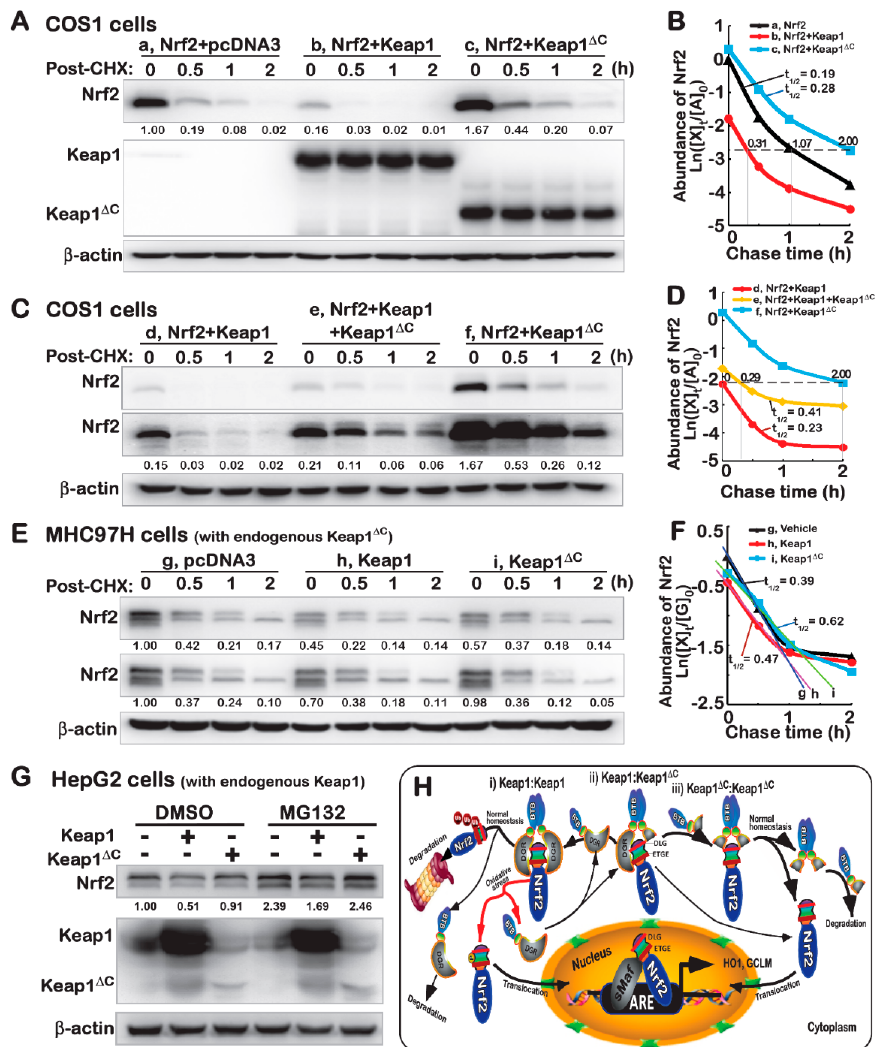
Figure 5. Keap1 Δ C has an antagonist effect on the Keap1-mediated turnover of Nrf2. ( A – D ) COS-1 cells were transfected with an Nrf2 expression plasmid alone or plus other plasmids V5-Keap1, V5-Keap1 Δ C or both, and then treated with 50 μ g/mL of cycloheximide (CHX) for distinct indicated lengths of time. The total lysates were determined by Western blotting with antibodies against Nrf2, Keap1, or its V5 tag, respectively. Subsequently, the intensity of blots was quantified and shown on the bottom ( A , C ). Of note, relative abundances of Nrf2 and its stability were determined with a changing half-life within distinct setting status, which were calculated and shown graphically ( B , D ). ( E , F ) MHCC97H and ( G ) HepG2 cells were transfected with an expression construct for V5-Keap1, V5-Keap1 Δ C or empty plasmids, before being treated with 50 μ g/mL of CHX for indicated times or 10 μ Mol/L of MG132 for 4 h, prior to being harvested in a lysis buffer. Then, distinct abundances of endogenous Nrf2 proteins were examined by immunoblotting ( E , G ). The stability of endogenous Nrf2 protein was also determined with a varying half-life within distinct setting contexts, which was shown graphically ( F ). ( H ) A model is proposed to give a clear explanation of Keap1 Δ C , acting as a dominant-negative competitor of Keap1. This is due to the fact that Keap1 Δ C can occupy the place in the formation of an invalid dimer with Keap1 or itself, no matter whether it only retains less or no ability to inhibit Nrf2. It is important to note that this mutant Keap1 Δ C has an antagonist effect on Keap1-mediated turnover of Nrf2 by proteasomal degradation pathway. In addition, upon dissociation of Nrf2 from Keap1, the CNC-bZIP factor will be allowed for spatiotemporal translocation into the nucleus before transactivating ARE-driven cytoprotective genes against oxidative stress or other biological